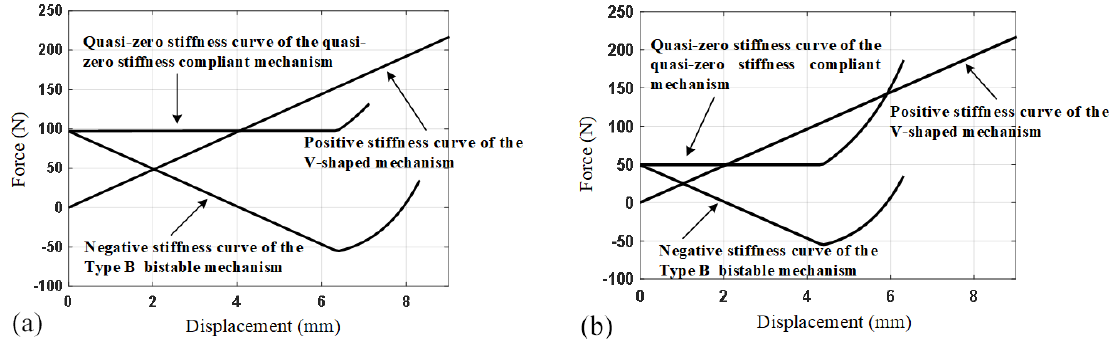
Figure 14. Different quasi-zero stiffness curves with the bolt screwing into different displacements. (a) The bolt is screwed into 3mm. (b) The bolt is screwed into 5mm.